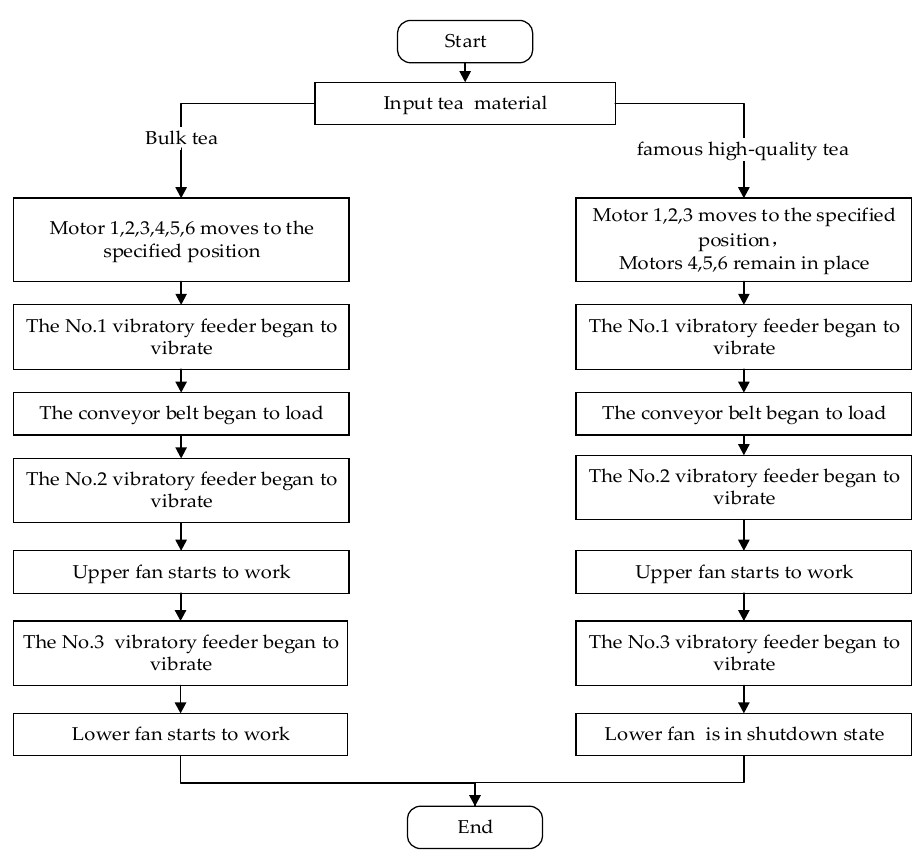
Figure 4. Block diagram of operation of double-layer tea winnowing machine.